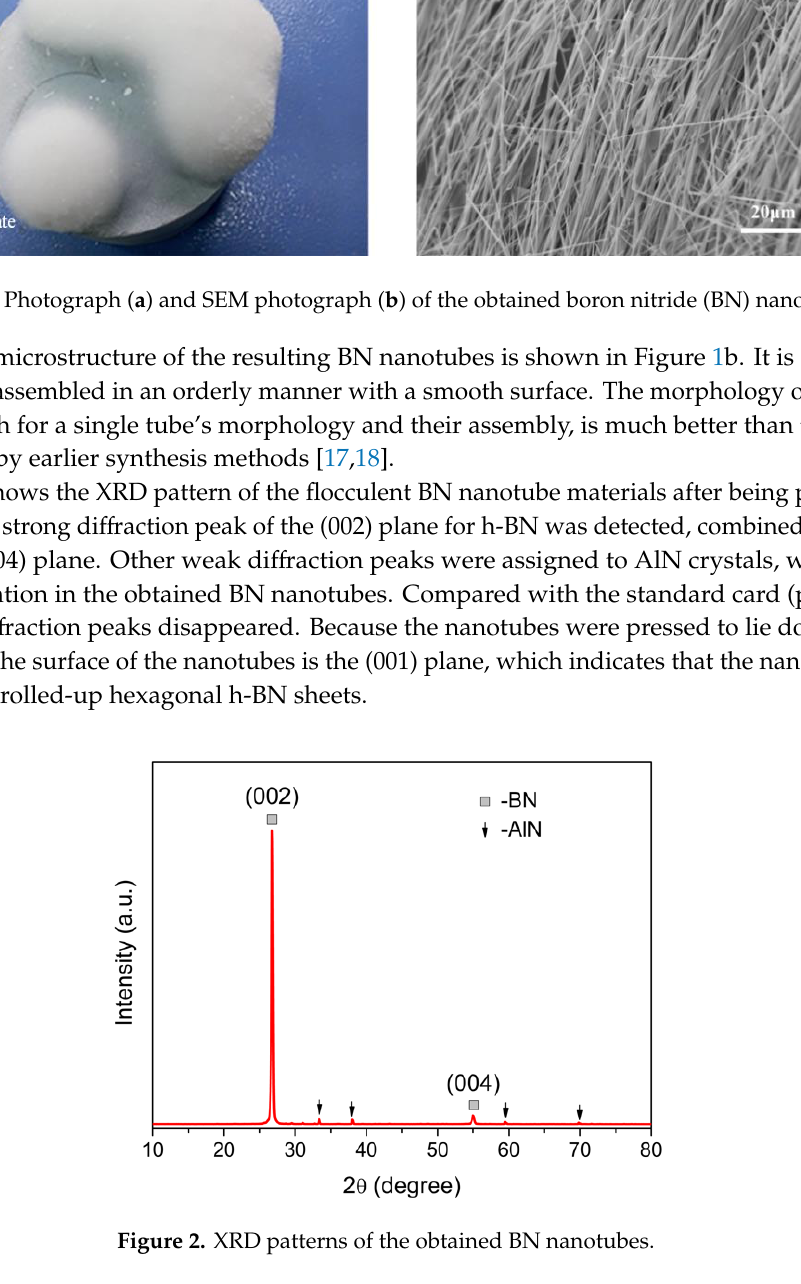
Figure 2. XRD patterns of the obtained BN nanotubes.